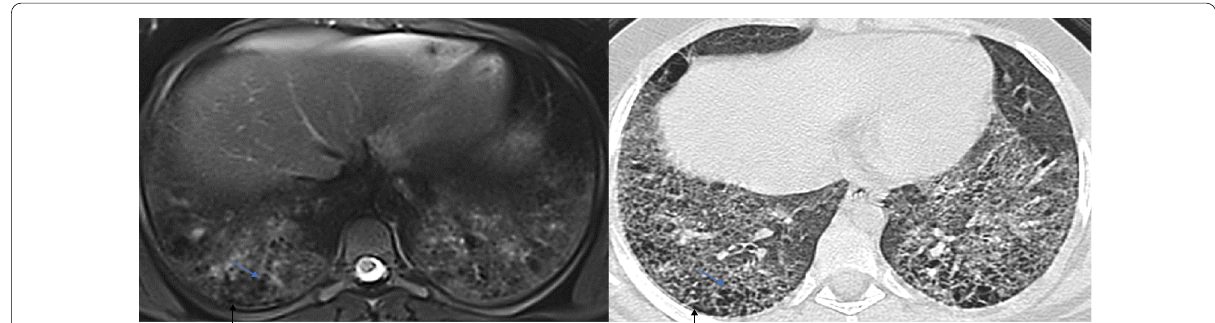
Fig. 4 A 10-year-old female diagnosed as interstitial pulmonary fibrosis (usual interstitial pneumonia), T2 blade, and comparable HRCT cut; both show bilateral fairly symmetrical basal reticulations, interlobular septal thickening, traction bronchiolectasis (blue arrows), bronchial wall thickening, and honeycombing (black arrows). CT score 18, MRI score